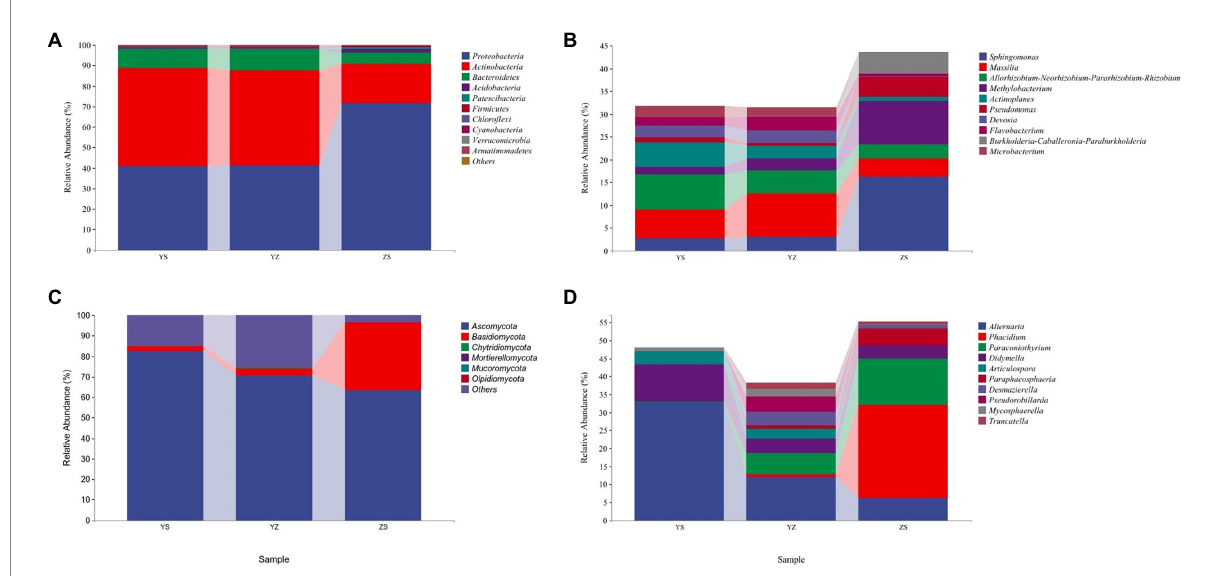
FIGURE 4 The relative abundance of microorganisms at pyhlum and genus levels in litter from different samples. (A) The relative abundance of dominant bacterial community at the phylum level; (B) The relative abundance of dominant bacterial community at the genus level (not showing others); (C) The relative abundance of dominant fungal community at the phylum level; (D) The relative abundance of dominant fungal community at the genus level (not showing others). YS: Populus × canadensis Moench; YZ: Populus × canadensis Moench- Pinus sylvestris var. mongolica ; ZS: Pinus sylvestris var.